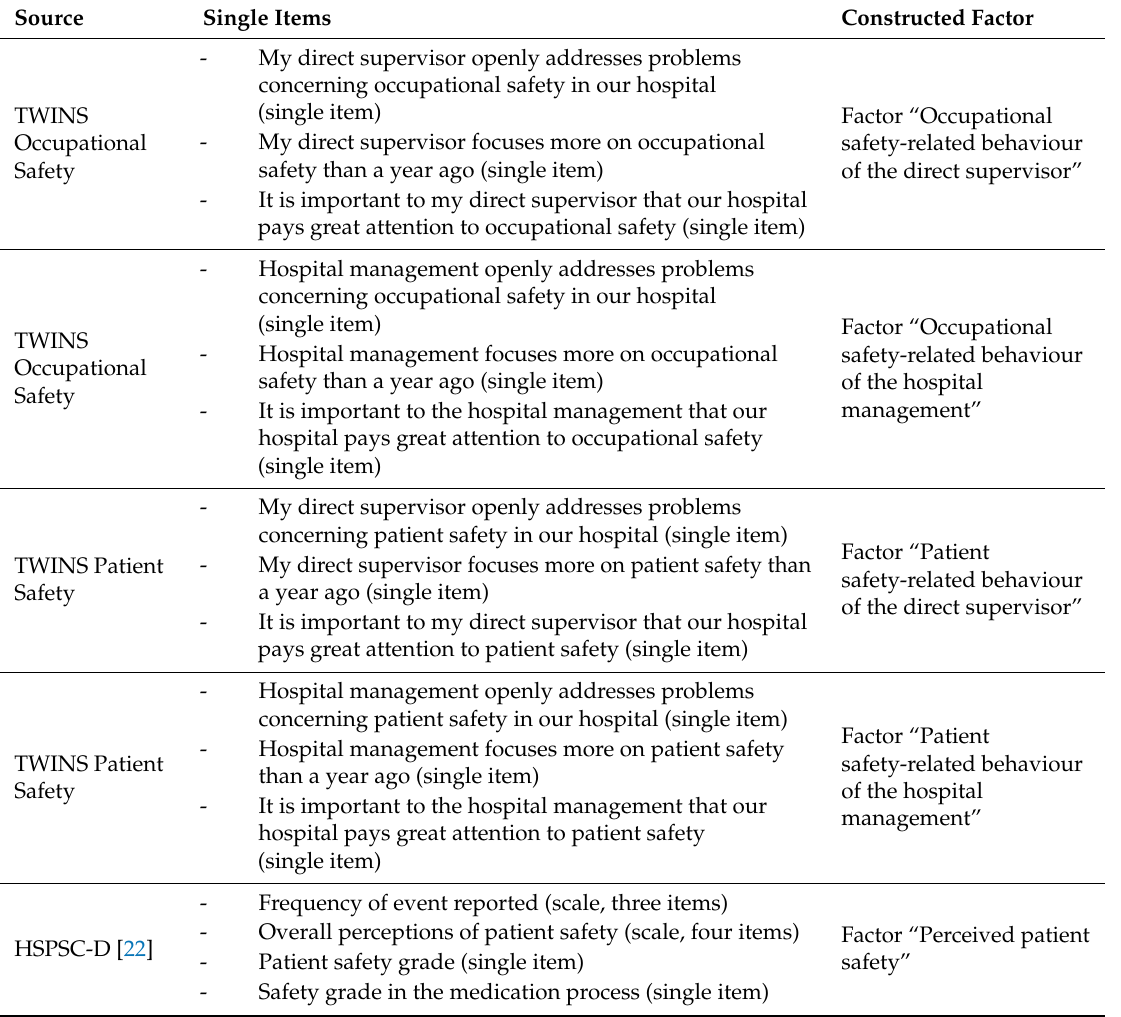
Table 2. Results of the exploratory factor